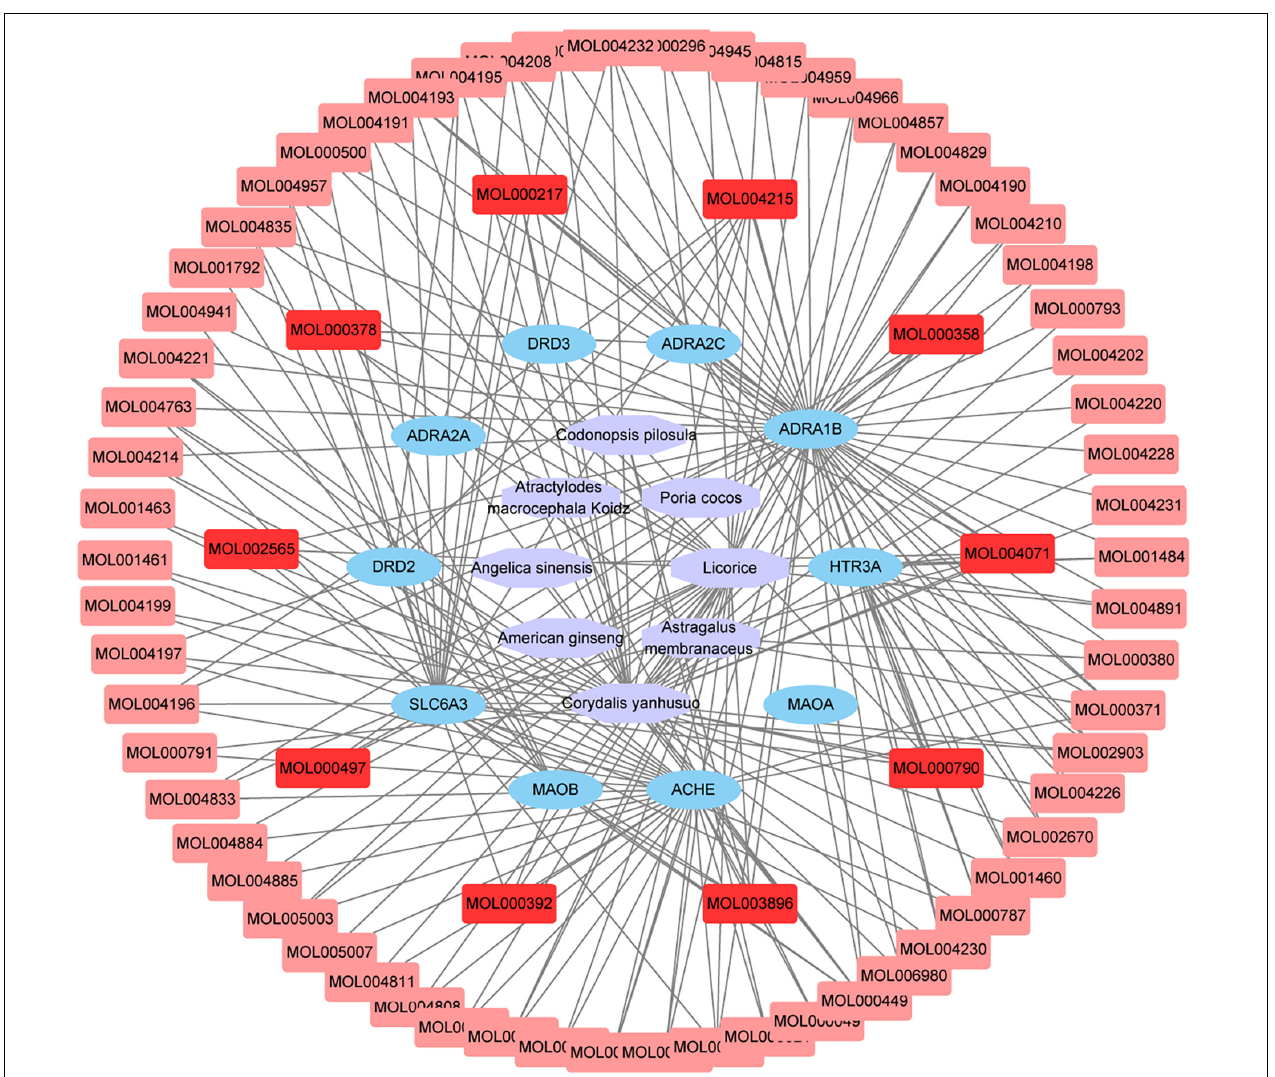
FIGURE 5 | Network chart of “Herb-Main active compounds-hub targets.” The purple polygons represented different herbs. The blue circle represented potential protein targets. The pink squares represented active compounds of herbs, and the red squares represented main active compounds. The edges represent the interactions between